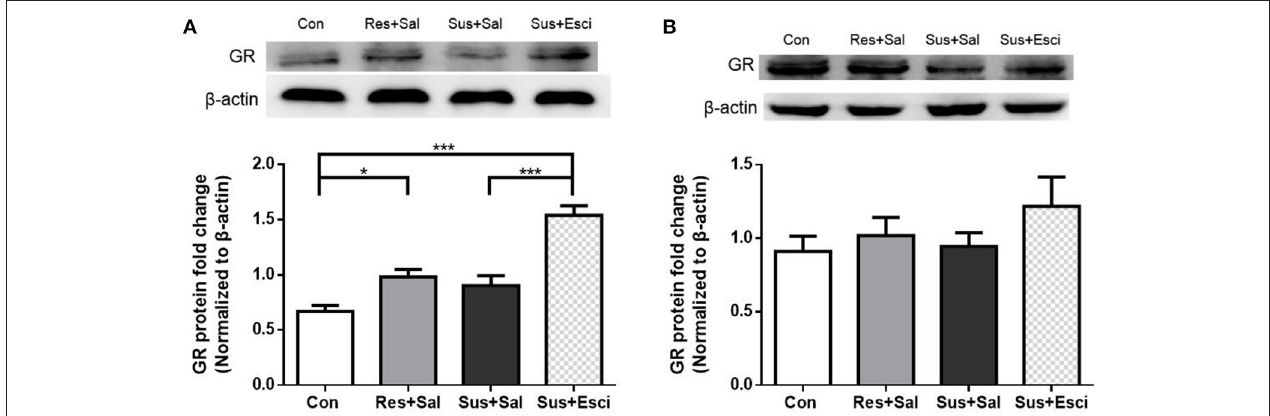
FIGURE 6 | Antidepressant could enhance the GR protein expression in hippocampus in susceptible mice. (A) GR protein expression in the hippocampus of mice after 4 weeks treatment ( n = 6/group). (B) GR protein expression in the hypothalamus of mice after 4 weeks treatment ( n = 6/group). All data are shown as